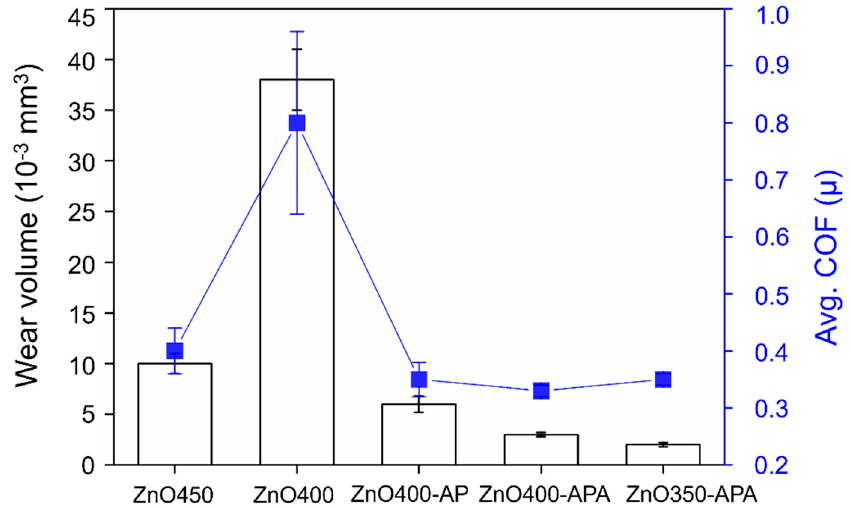
Figure 9. Wear volume and average coefficient of friction of ZnO coatings.